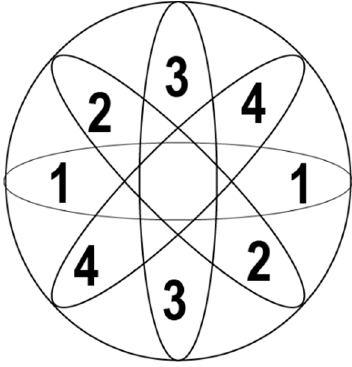
Figure 1. Core antenna beams of Impinj xArray reader.